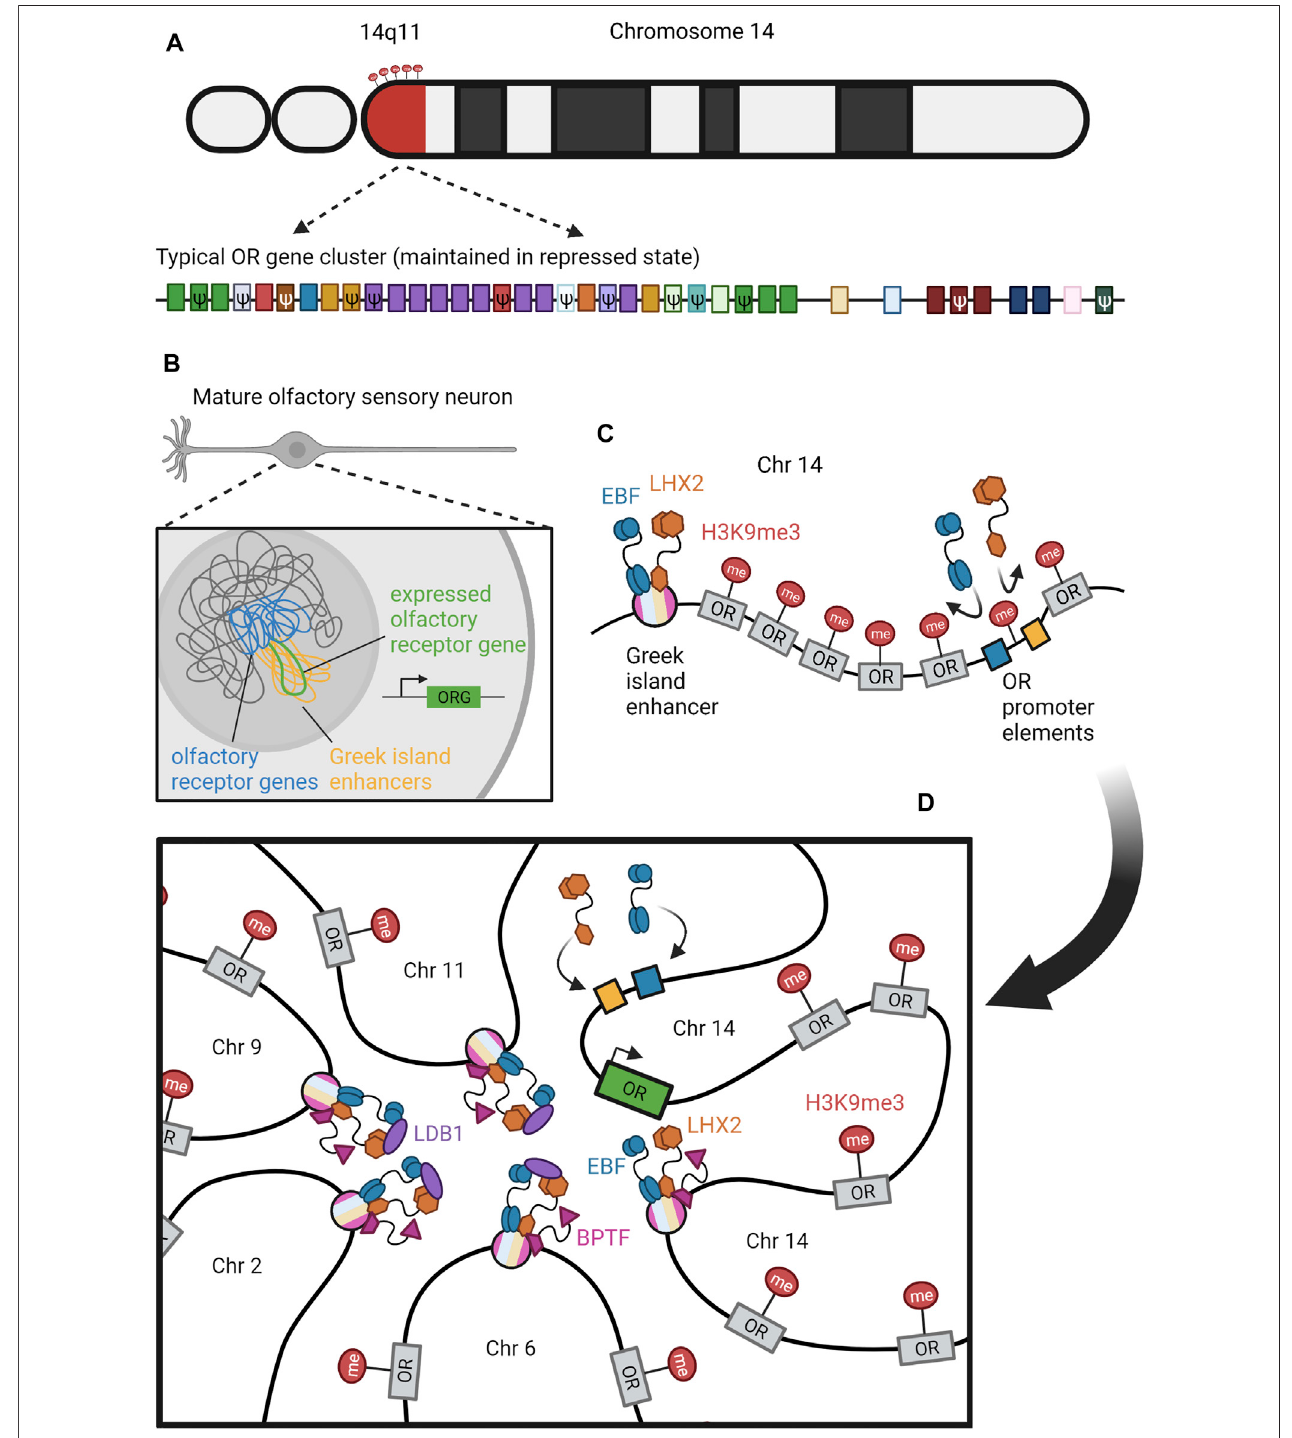
FIGURE 7 | Organization and Expression of ORs. (A) Olfactory receptor ( OR ) genes are distributed throughout all chromosomes in the human genome except for chromosome 20. An example of a typical OR gene cluster, maintained in a repressed state by histone methylation, is shown on region 14q11 of chromosome 14. H3K9me3 is provided as an example of a heterochromatic modi fi cation (red lollipops). A close-up of this cluster reveals an array of functional and pseudo ( ψ ) OR genes belongingtovarious(color-coded)subfamilies(Olenderetal.,2008). (B) Inmatureolfactorysensoryneurons, OR genesareclusteredintoconstitutivechromatin in thecenterofthenucleus(Clowneyetal.,2012;Armelin-Correaetal.,2014;Armelin-Correaetal.,2015;Tanetal.,2019).Greekislandenhancers(yellowstrands)thatare cis to inactive OR genes (blue strands) will form trans interactions to cluster around one active OR gene (green strand). Panel (C,D) detail the temporal progression